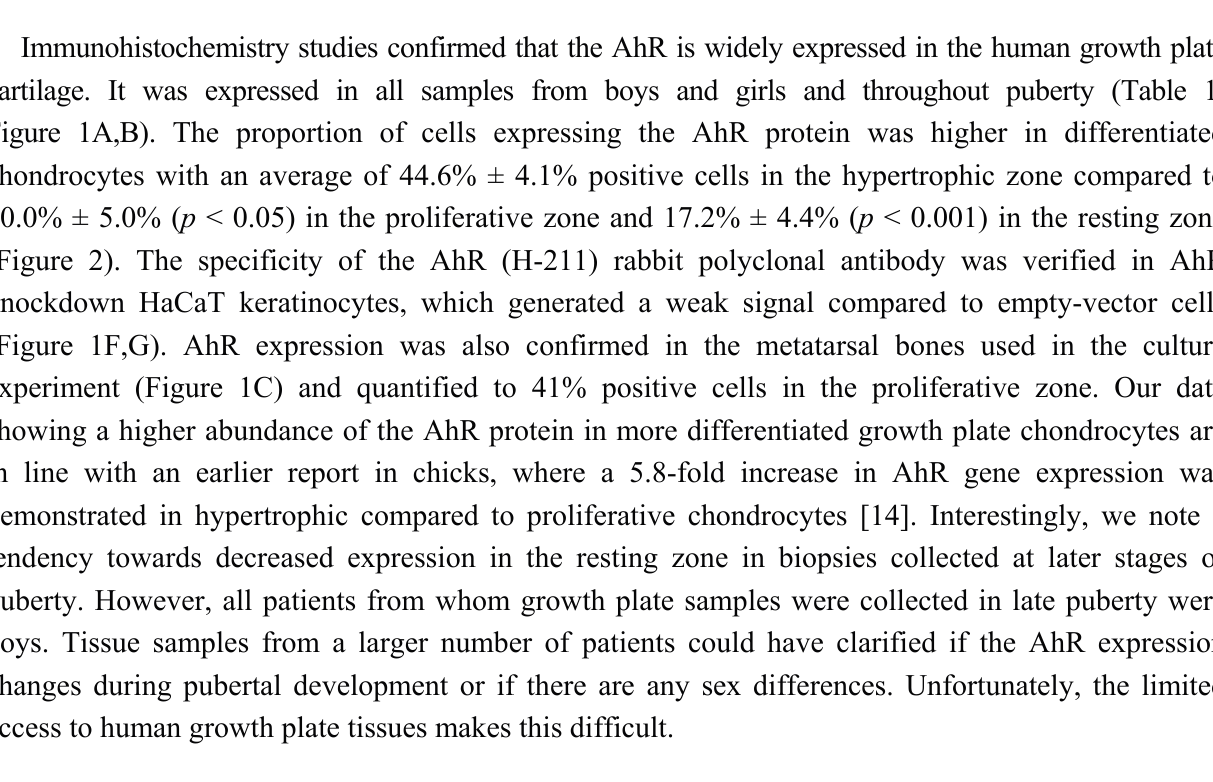
Table 1. Descriptive data of the patients from whom tissue samples were collected and the abundance of AhR protein expression in the different growth plate